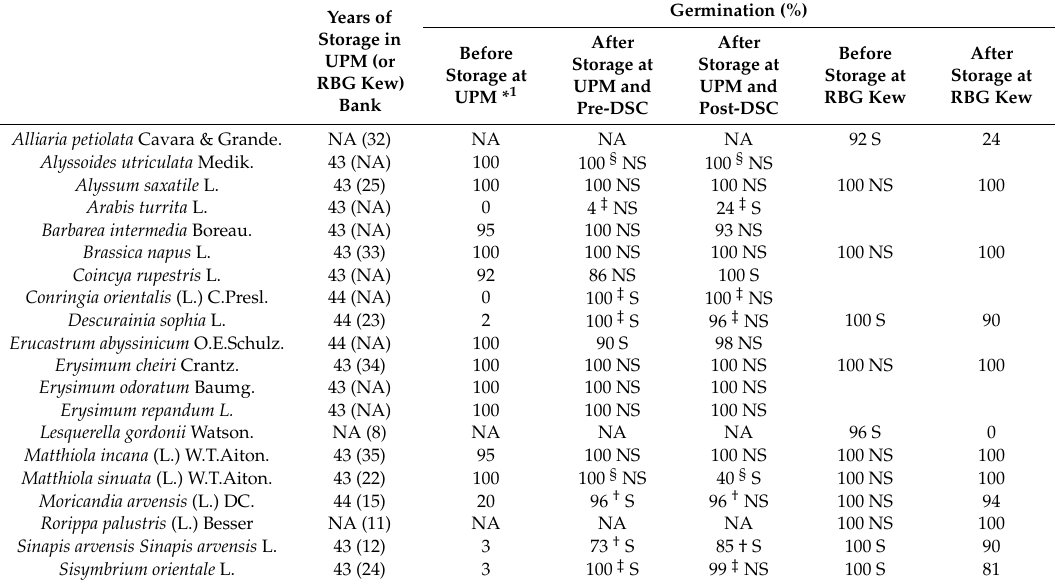
Table 1. Post-storage total germination (radicle emergence) of 20 Brassicaceae species after 43–44 years in the Plant Germplasm Bank—Universidad Polit é cnica de Madrid (UPM) seed bank at c. − 5 ◦ C and low moisture content (dry indicator silica gel) or after 12–35 years at the Millennium Seed Bank of the Royal Botanic Gardens (RBG) Kew at − 20 ◦ C after drying to 15% relative humidity. After storage (and di ff erential scanning calorimetry [DSC]), seeds were germinated at 25 / 15 ◦ C (8 h light / 16 h